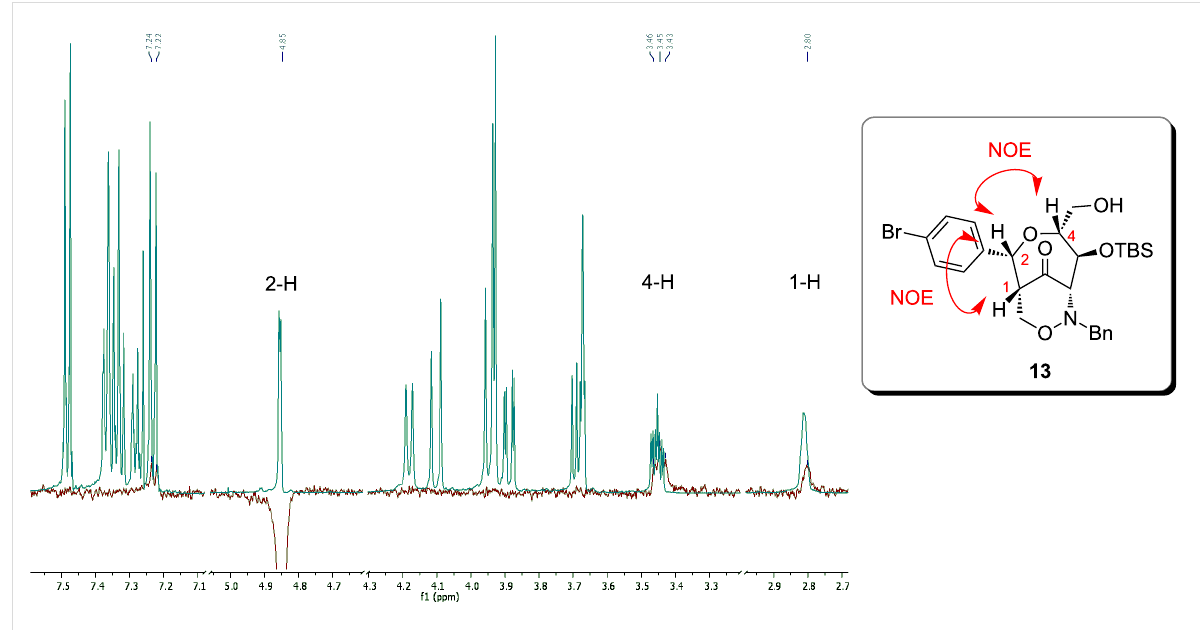
Figure 2: GOESY–NMR spectrum (CDCl 3 , 500 MHz) of bicyclic 1,2-oxazine 13 : irradiation of the 2-H proton. [GOESY = gradient enhanced nuclear Overhauser effect spectroscopy]